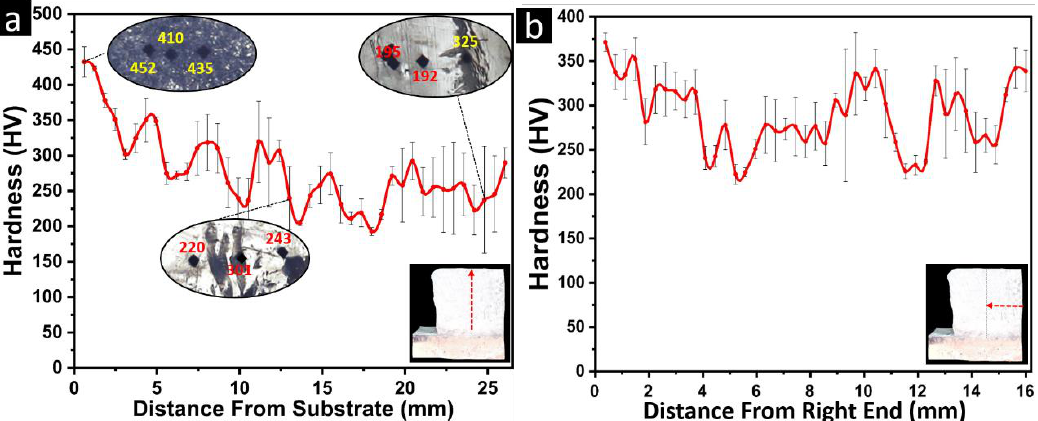
Figure 20. The Vickers micro-hardness measurement obtained ( a ) towards the increased build height and ( b ) towards the right of the sample at 12 mm build height.